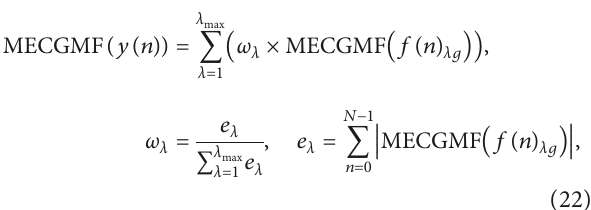
( t ) , (b) harmonic signal y 2